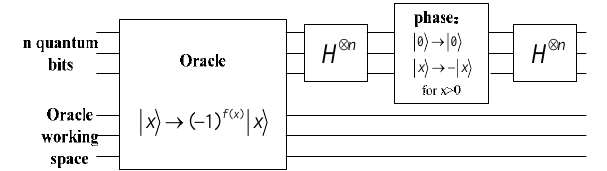
Fig. 4. Procedure of Grover